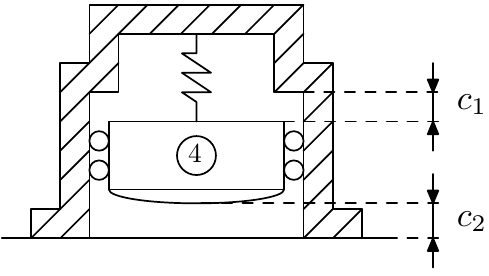
Fig. 3 Model of vibrating system, damping device without damper.